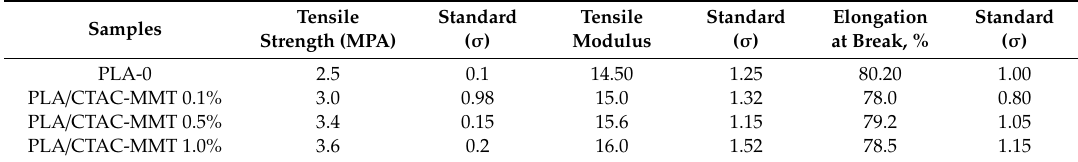
Table 4. Tensile strength and elongation at break data for PLA and PLA / CTAC-MMT composites.